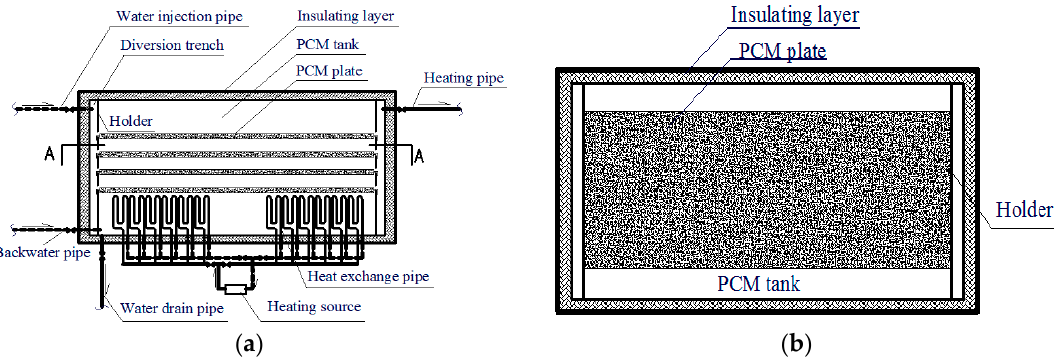
Figure 6. ( a ) Front view of the phase-change material (PCM) storage tank; ( b ) A–A cross section of the PCM storage tank.